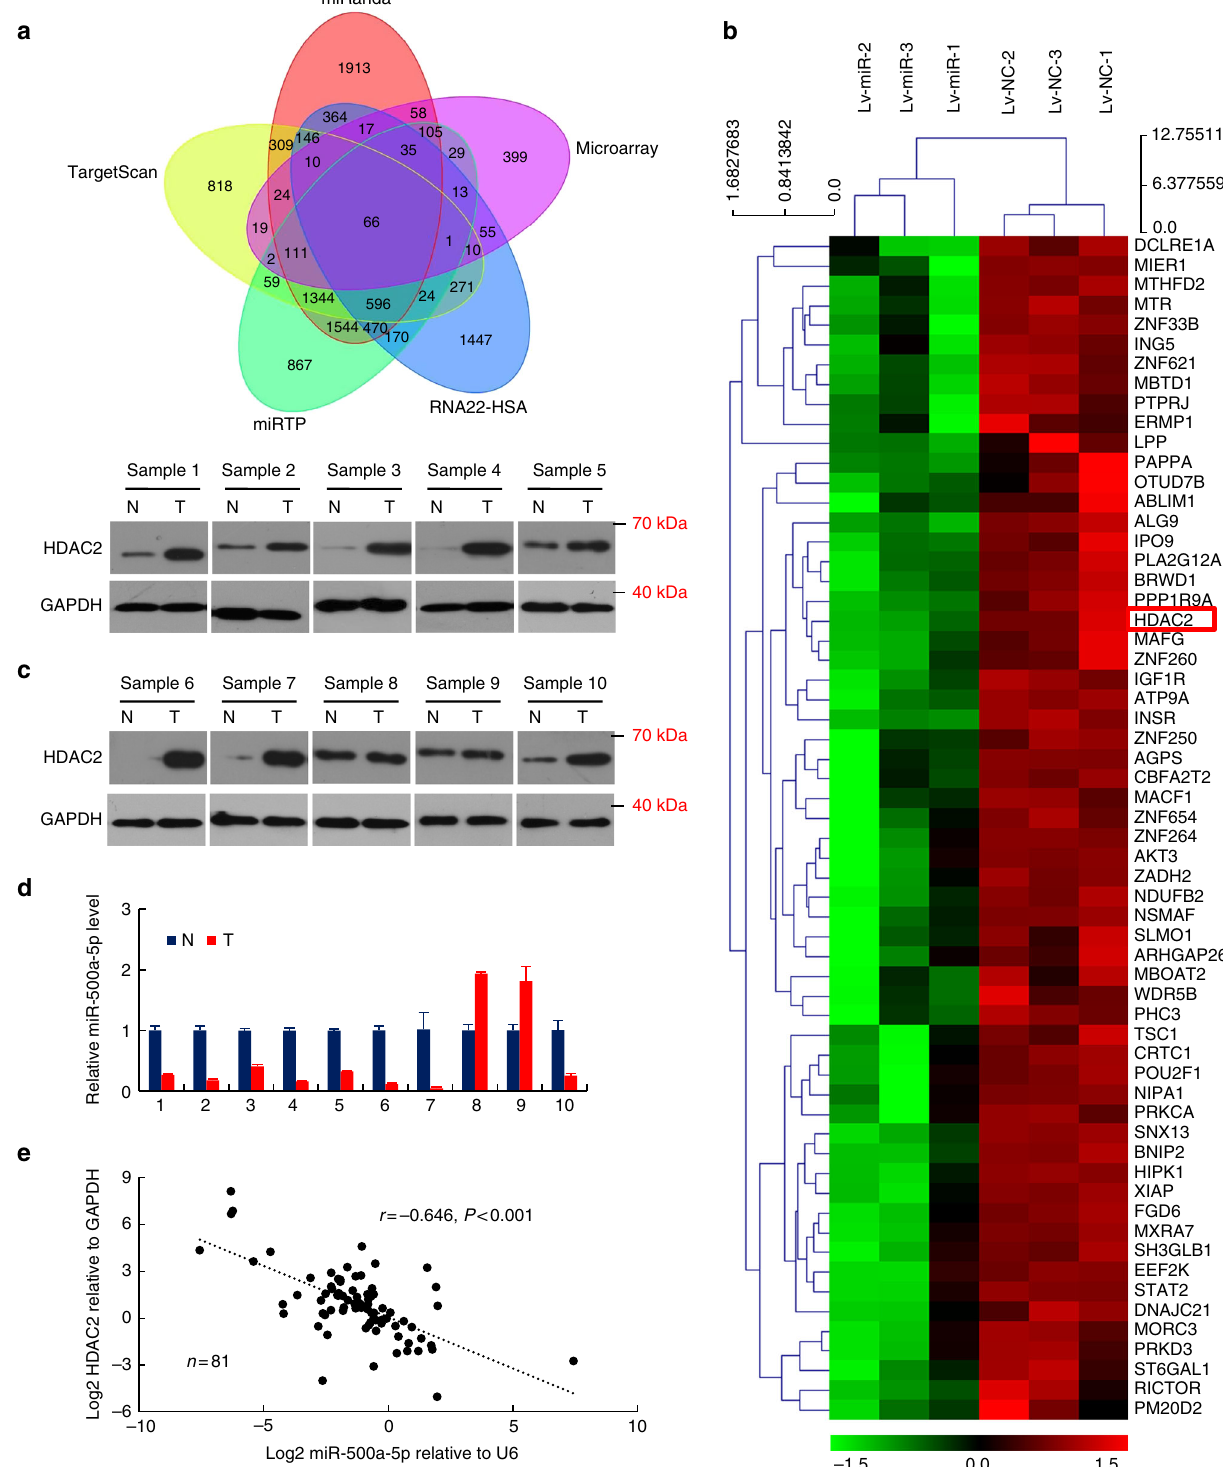
Fig. 2 miR-500a-5p directly targets HDAC2 in CRC. a The fi ve-way Venn diagram indicates the numbers of genes that overlapped in four publicly available bioinformatics algorithms (miRanda, TargetScan, miRTP, RNA22-HSA) and the microarray-based miR-500a-5p signature. b The heat map was based on 60 candidate genes that were down-regulated in LoVo cells. Red color represents an expression level above mean, green color represents an expression lower than the mean. c and d HDAC2 protein and miR-500a-5p expression in ten freshly collected CRC biopsies using western blot and qRT-PCR analyses. e In human CRC tissues, HDAC2 was negatively correlated with miR-500a-5p expression. All results were expressed as the mean of three to four independent experiments ± SD. Linear regression analysis. r = – 0.646, **** P <